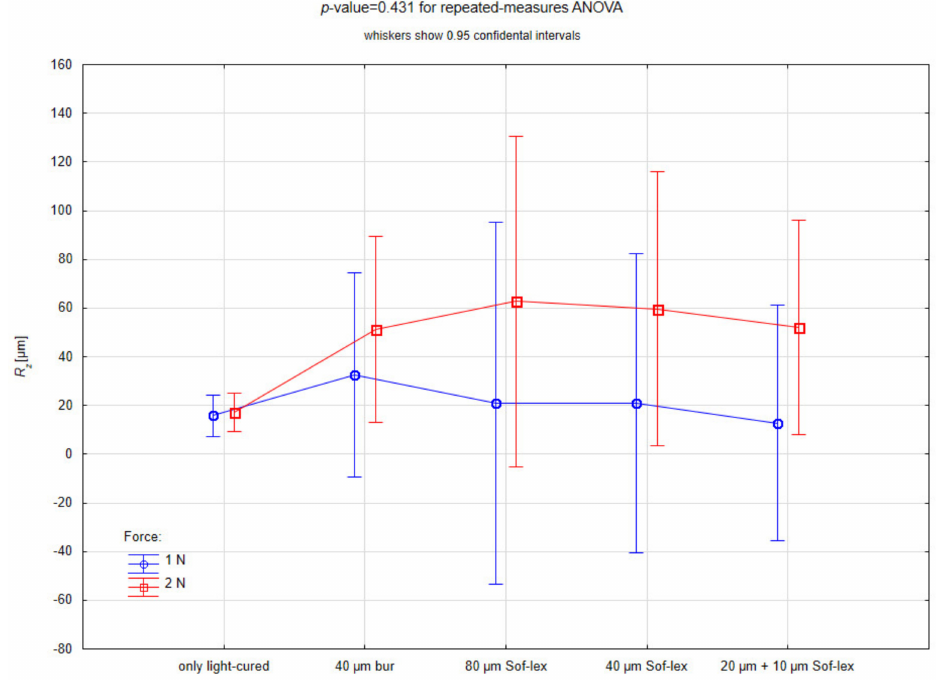
Figure 3. Repeated-measures analysis of variance for R z values in the individual polishing steps depending on the press-on